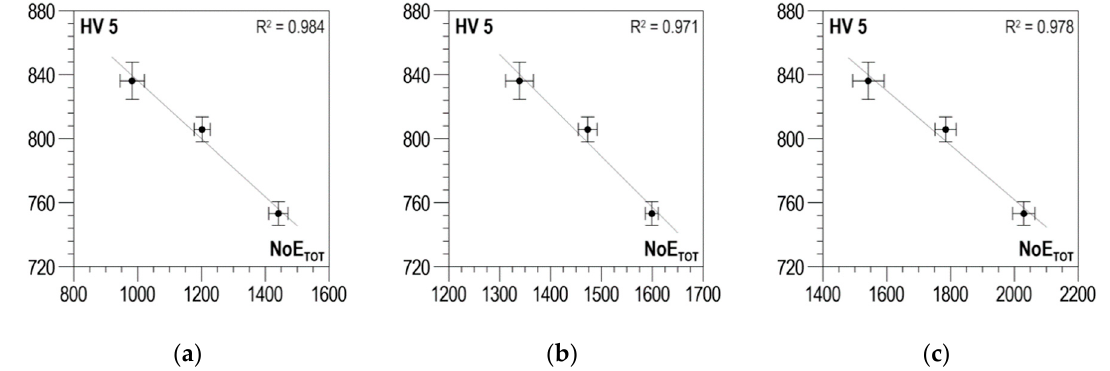
Figure 15. Linear correlations between NoE TOT and HV5 hardness—Configuration C1 ( a ) parallel direction, U g = 0.8 V; ( b ) normal direction, U g = 0.74 V; ( c ) absolute value, U g = 0.79 V.